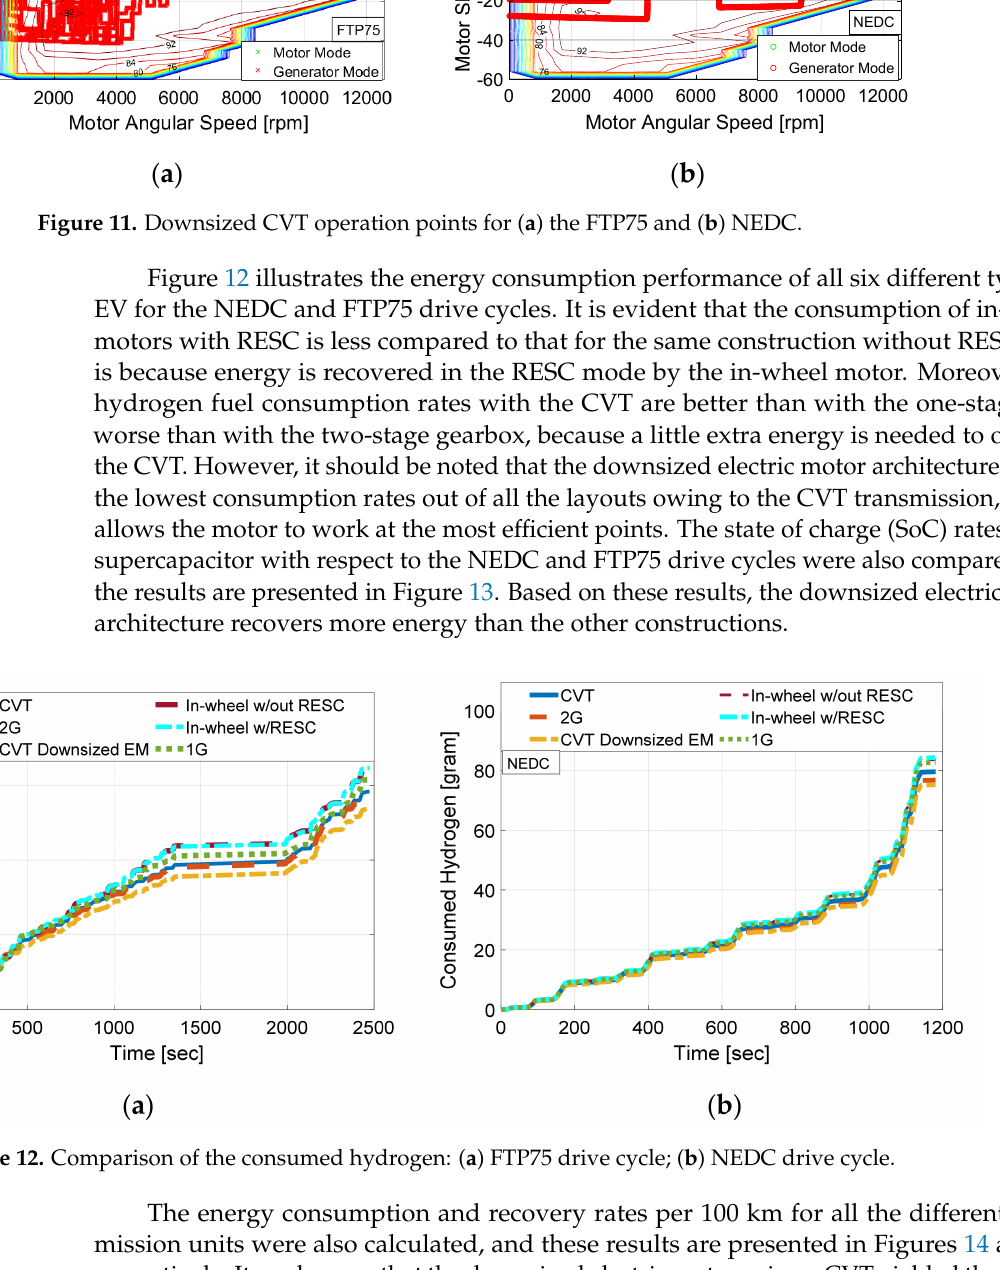
Figure 10. Comparison of the main subsystem masses.